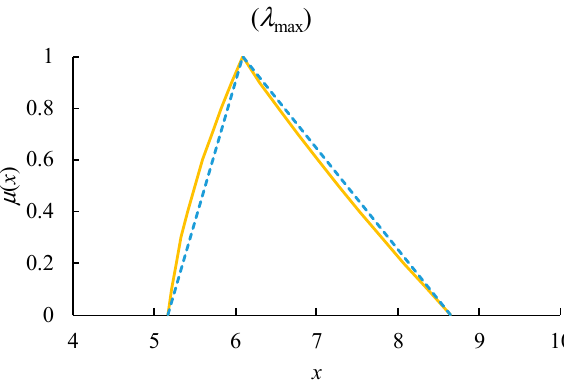
Figure 1. Non-TFN nature of a fuzzy eigenvalue.